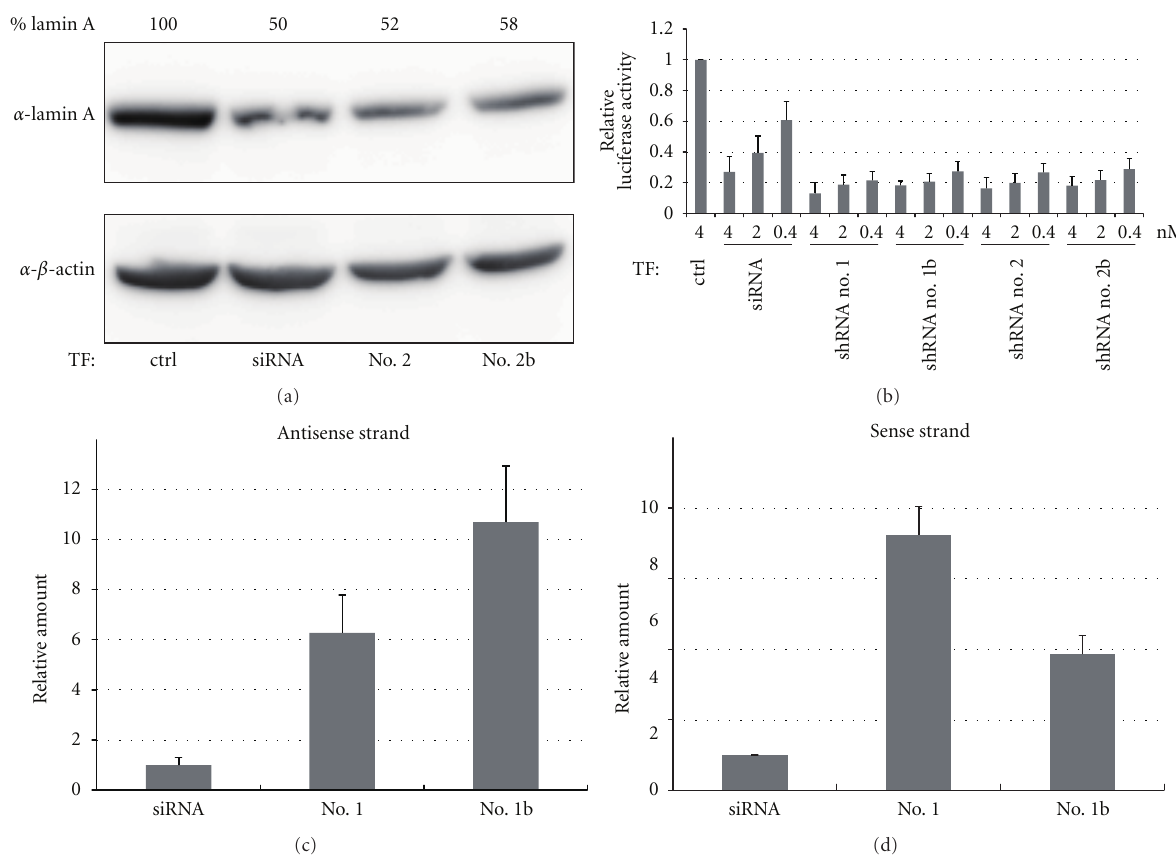
Figure 2: Comparison of the RNAi activity between synthetic shRNAs and their corresponding siRNAs. (a) The RNAi activity of siRNAs and shRNAs was analyzed by immunoblotting. (b) The RNAi activity was monitored by a reporter assay system. The luciferase activity ratio for the control siRNA (ctrl) was set as 1. (c), (d) The incorporation of transfected small RNA into the RISC was analyzed by qRT-PCR. Data were normalized against the amount of miR-21 in the RISC. The amount of siRNA incorporated was set as 1. Each graph point in (b), (c), and (d) represents the average (with s.d.) of three independent